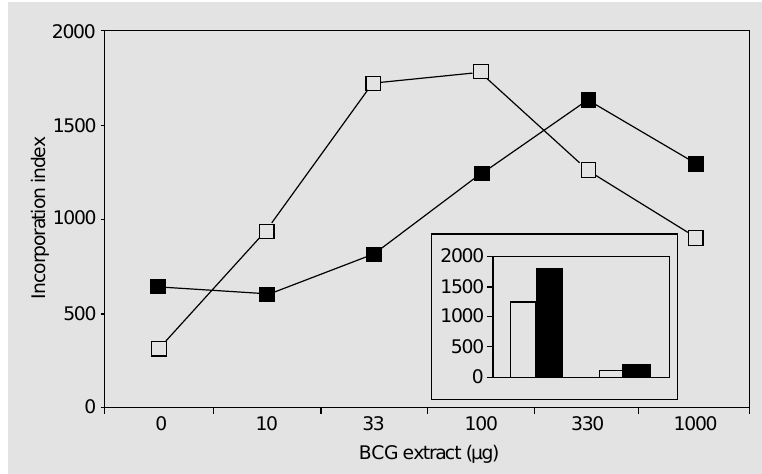
Figure 3 - In vitro proliferation of spleen cells harvested from BALB/c mice inoculated with O-BCG (open squares) or ID-BCG (filled squares) vaccine. Samples of spleen cells previously depleted of adherent cells were challenged with different doses of the corresponding BCG extract at 37 o C. Cell proliferation was assessed by [ 3 H]-thymidine incorporation and ex- pressed as incorporation index. Proliferation of CD4-bearing lymphocytes was inhibited by pretreating the spleen cells with the specific monoclonal antibody GK-1.5 (inset).